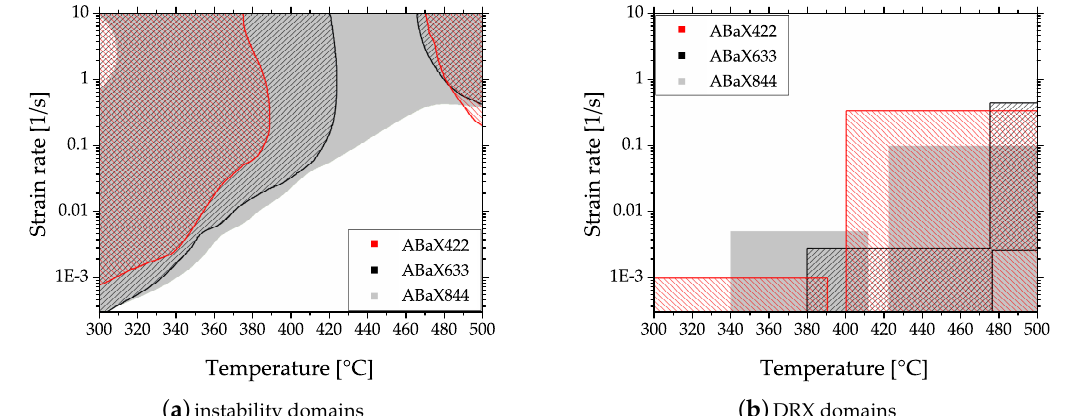
Figure 20. Comparison of the forming behavior at 0.5 strain of ABaX alloys with rising alloying content. Showing ( a ) domains of instability and ( b ) Dynamic recrystallization (DRX) domains, based on the processing maps calculated in References [115–117].